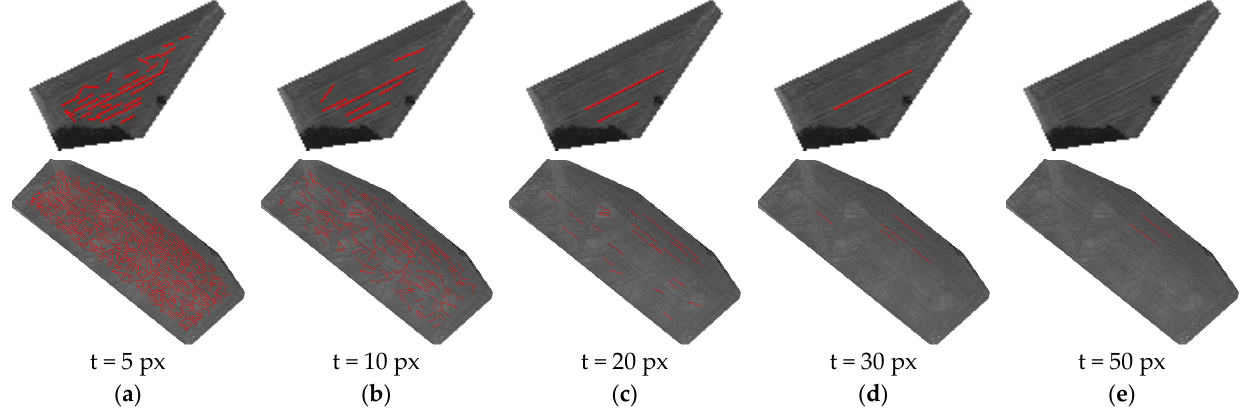
Figure 14. Results for increasing Length Threshold t from ( a ) to ( e ) for one small parcel 1421 (1551 m 2 , winter oats) in the upper row and one medium–large parcel 1324 (25,456 m 2 , spring barley) in the bottom row (images of land parcels are not to scale; dt = 2 1/2 px, cth1 = 150, cth2 = 75); detected lines by FLD in red color; data source: [40,41].